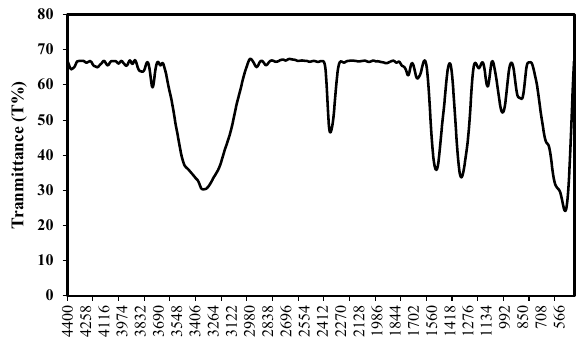
Figure 4. FTIR spectra of S4.